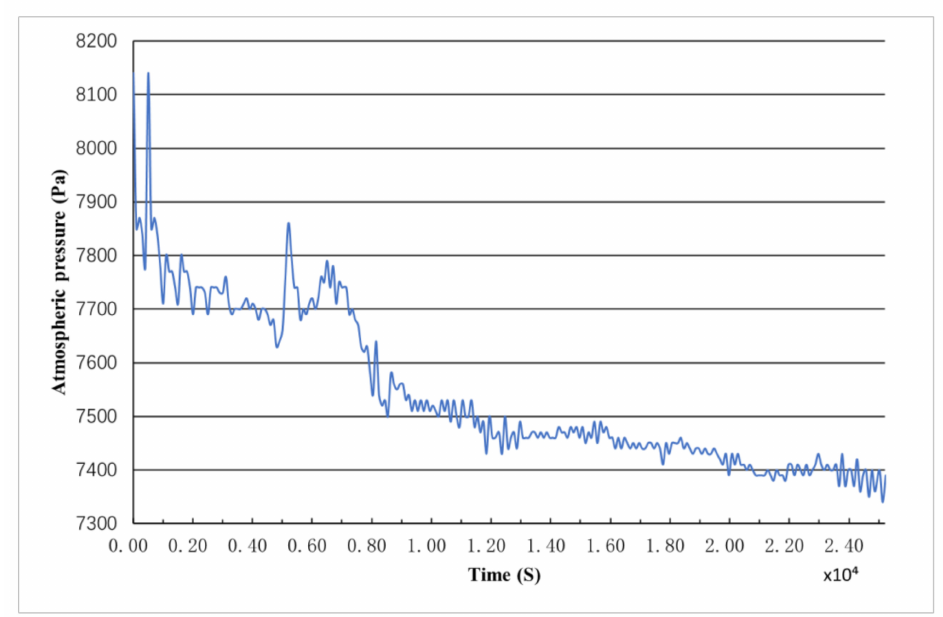
Figure 6. Measured atmospheric pressure during a flight test.